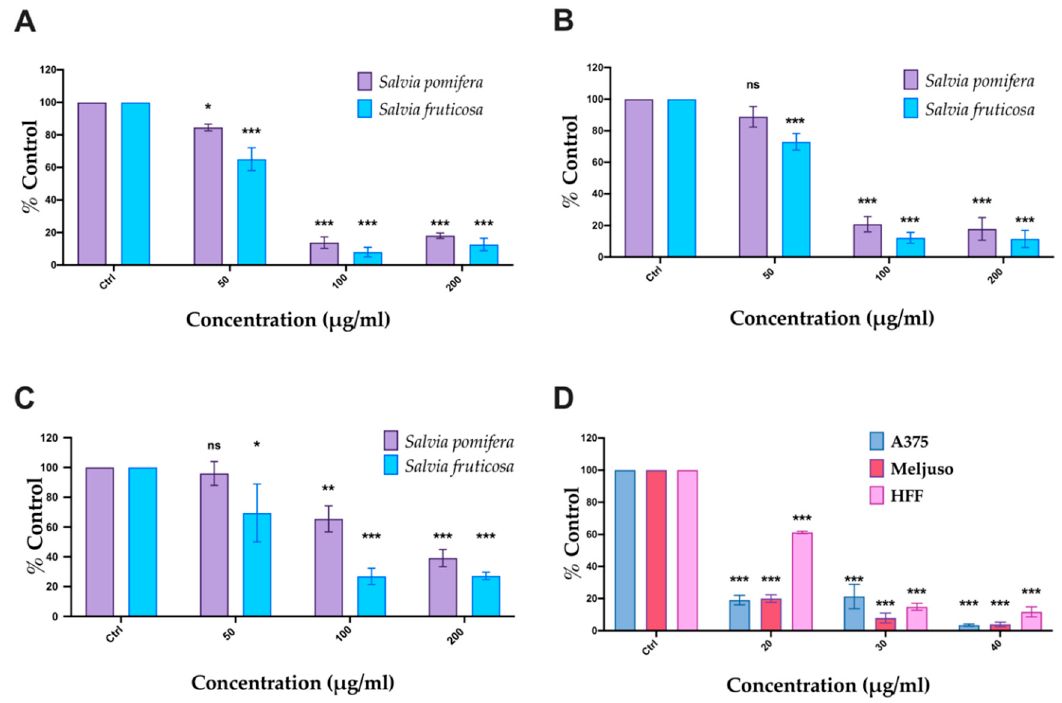
Figure 4. Antiproliferative activity of Salvia fruticosa Mill. (SF) and Salvia pomifera L. (SP) extracts evaluated by MTT assay. ( A ) A375, ( B ) Mel JuSo, and ( C ) human foreskin fibroblast (HFF) cells were incubated with SP or SF extracts and ( D ) carnosic acid (CA) for 48 h. The data are the means ± S.E.M. of three independent experiments; * < 0.05, ** < 0.01 and *** < 0.001. Table 3. The Cytotoxicity of Salvia Methanolic Extracts and Carnosic Acid (CA). Results Present IC 50 Values After 48 h of Treatment, A375, Mel Juso, and Human Foreskin Fibroblast (HFF) Cells. Extract ( μ g/mL)